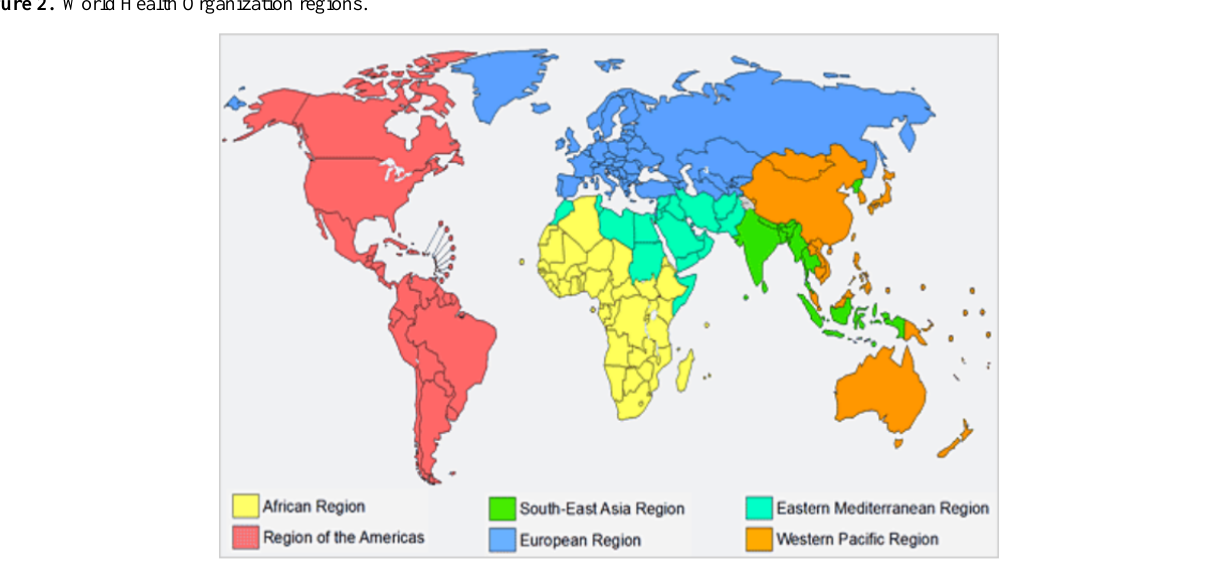
Figure 2. World Health Organization